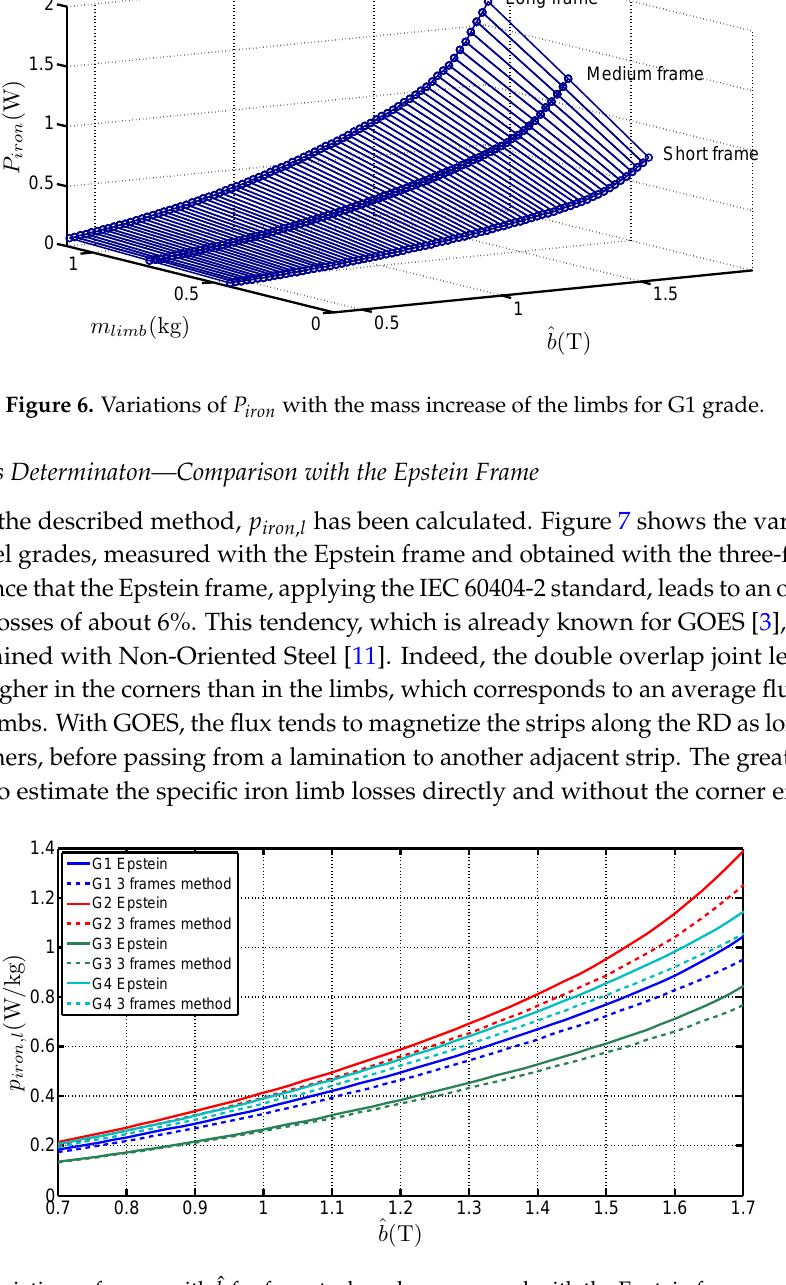
Figure 7. Variations of p iron , l with ˆ b for four steel grades, measured with the Epstein frame and obtained with the three-frame